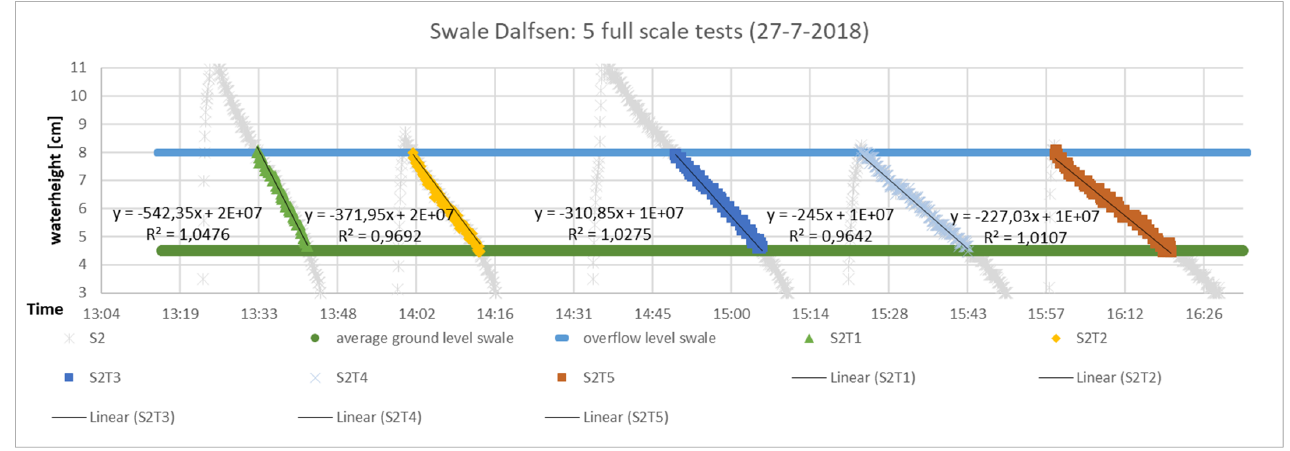
Figure 8. Empty curves swale 2 (S2) and 5 tests (T1–T5) in drought situation.